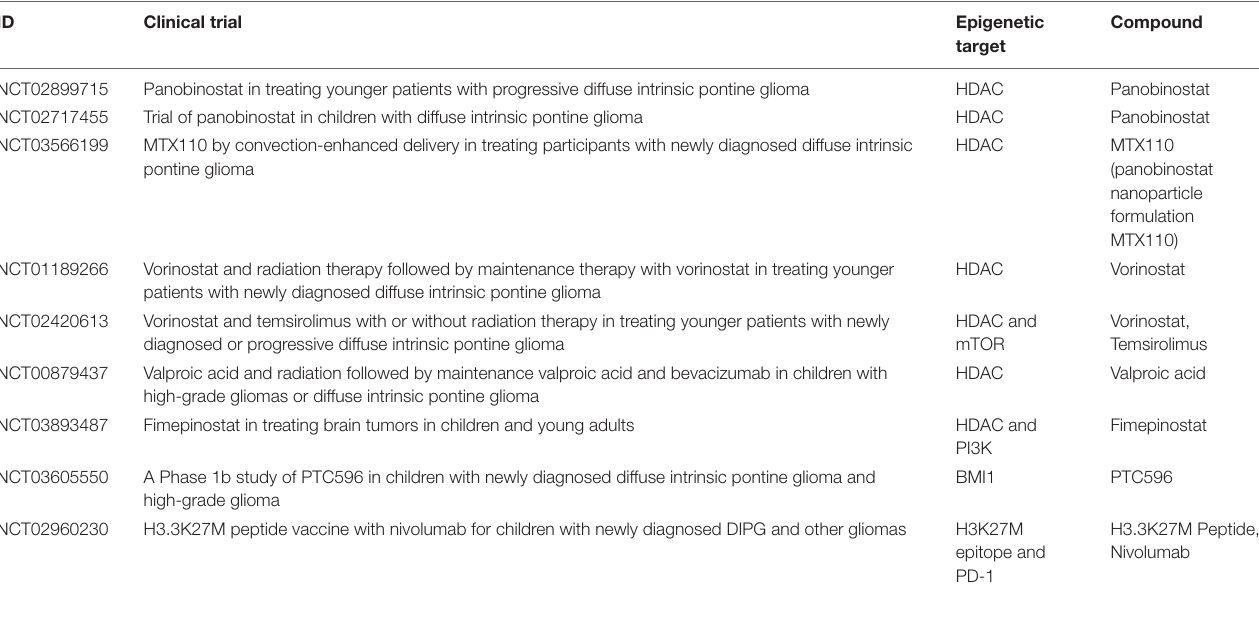
TABLE 1 | A summary of past and present clinical trials in pHGGs, which include epigenetic